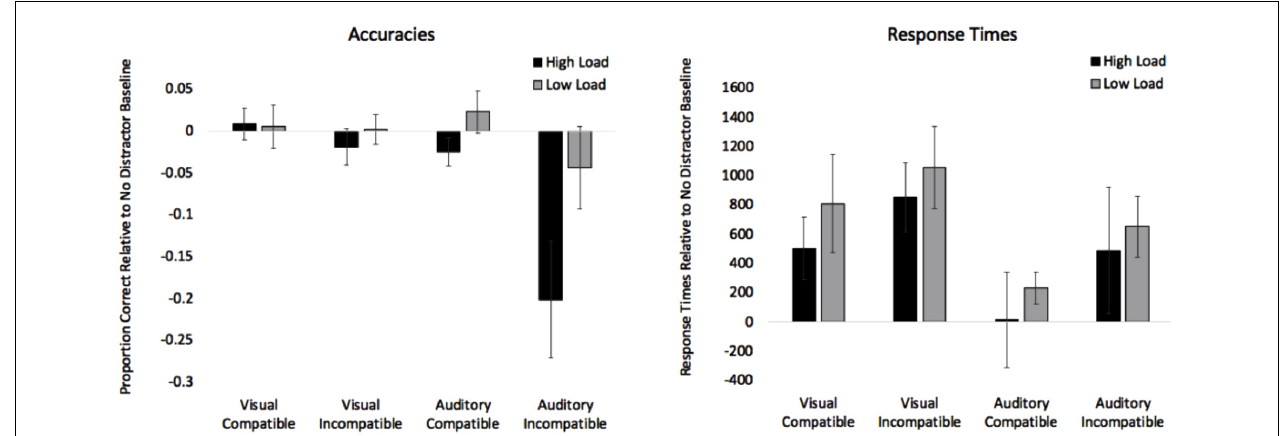
FIGURE 3 | Proportion of correct responses adjusted to the no distractor baselines (compatible – baseline and incompatible – baseline) are presented on the left. Values below 0 indicate interference. Response times adjusted to the no distractor baselines (compatible – baseline and incompatible – baseline) are presented on the right. Values above 0 indicate interference. Error bars denote Standard